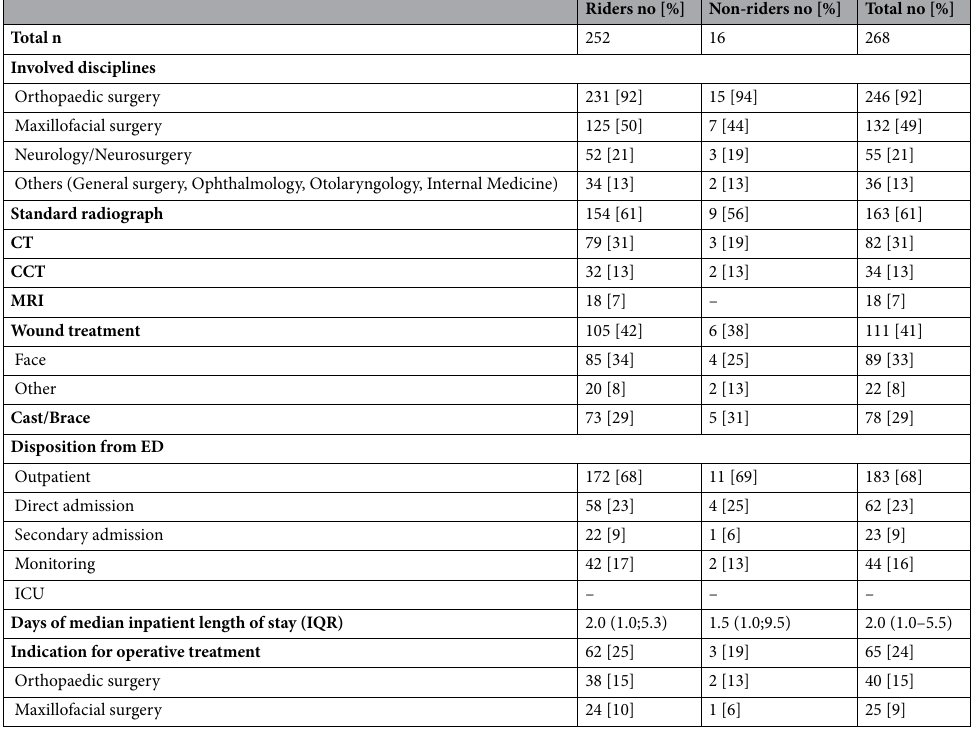
Table 4. Involved disciplines, means of diagnostics and treatment received by e-scooter riders and non-e- scooter riders.